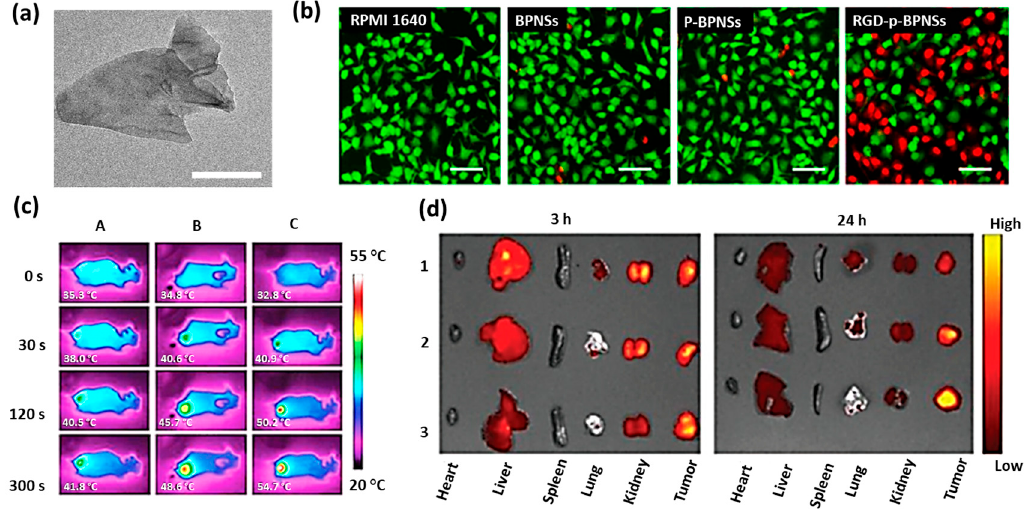
Figure 6. ( a ) TEM image of bare BPNSs with scale bar 50 nm. ( b ) Inverted fluorescence microscope images of A549 cells (scale bar 100 µ m) treated with RPMI 1640 cell culture medium, bare BPNSs, p-BPNSs (1-pyrenebutyric acid-modified BPNSs), and RGD-p-BPNSs after 30 min of incubation followed by NIR irradiation laser (808 nm, 1.0 W / cm 2 , 10 min). Propidium iodide (red, dead cells) and Calcein-AM (green, live cells) were used for staining the cells. Adapted with permission from [104]. ( c ) In vivo IR thermal images of mice treated with A: PBS; B: BP@PDA-PEG; C: BP@PDA-PEG-Apt. ( d ) Ex